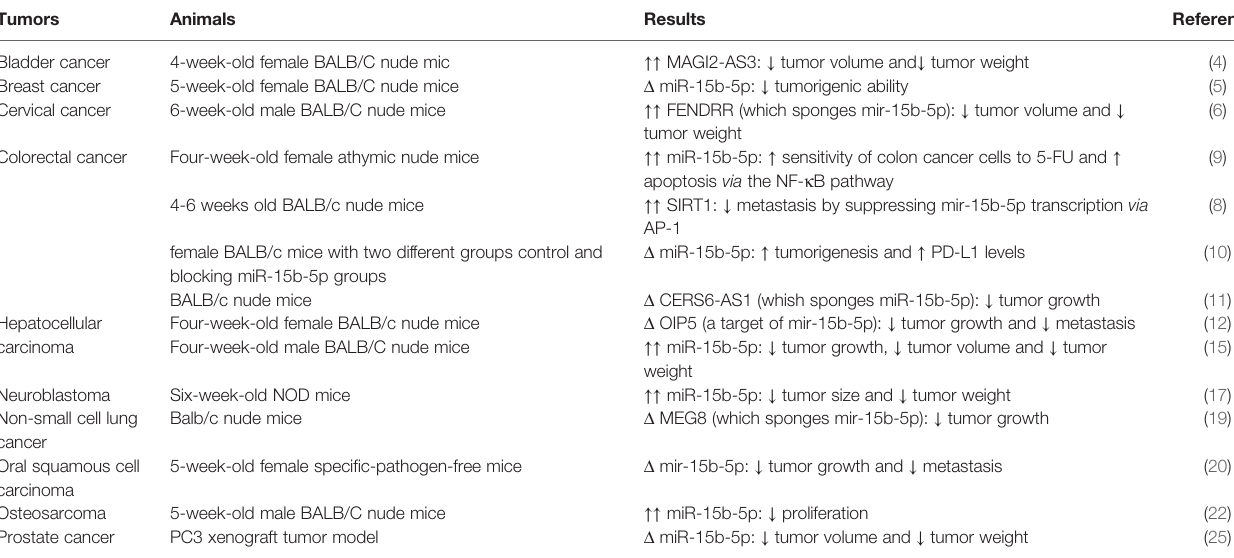
TABLE 2 | Summary of animal studies on the role of miR-15b-5p in cancers ( D , knock-down or deletion). Tumors Animals Results Reference Bladder